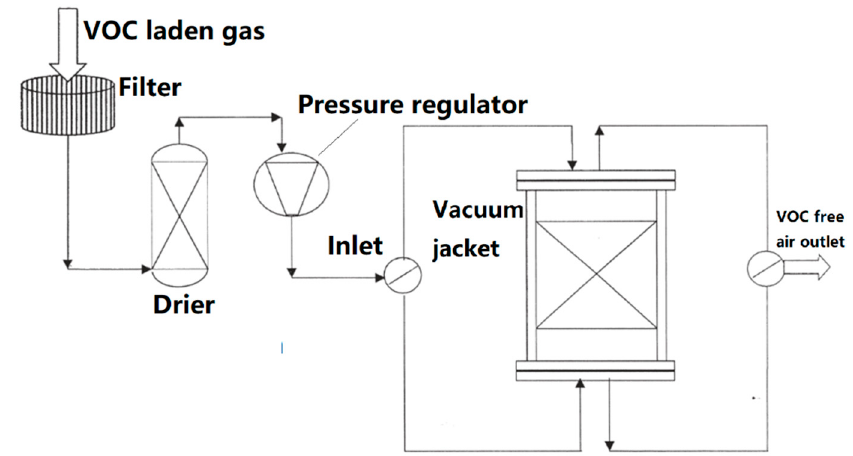
Figure 6. Schematic diagram of a reverse flow reactor. Reprinted with permission from [26], 2000, Elsevier Ltd.